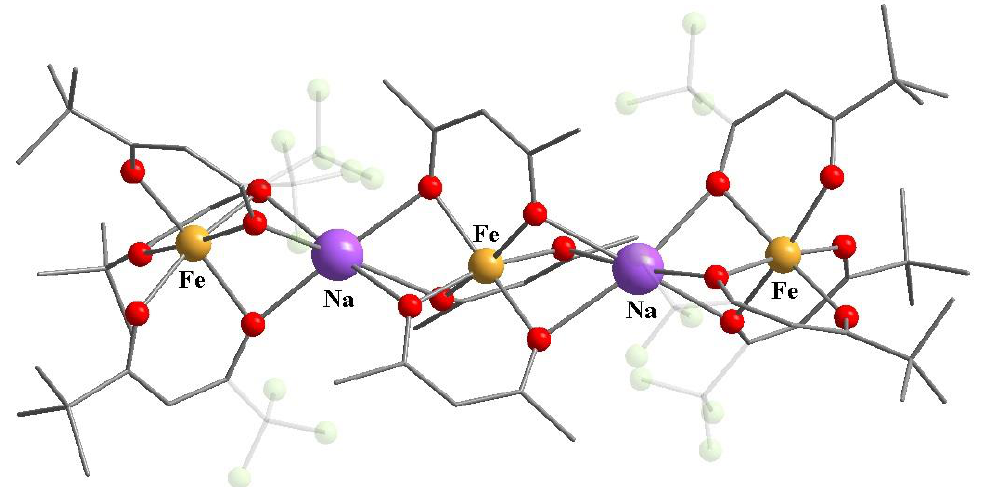
Figure 6. Molecular structure of 16 [68]. Hydrogen atoms have been omitted, CF 3 groups of hfac are transparent for clarity. The cif has been retrieved from CCDC. CCDC number is 1998878.